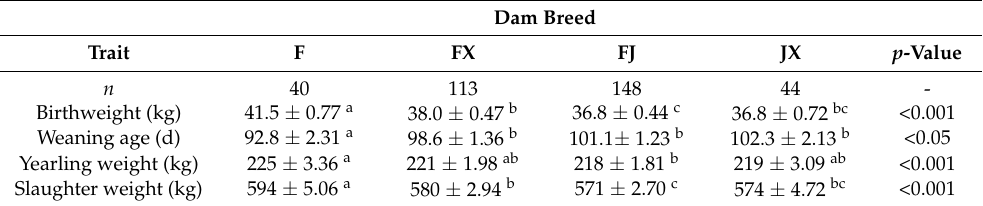
Table 2. Growth traits for beef-cross-dairy-breed progeny from Friesian (F), Friesian-cross (FX), Friesian–Jersey (FJ) and Jersey-cross (JX) dams. Values are least squared means, ± standard error of the mean.